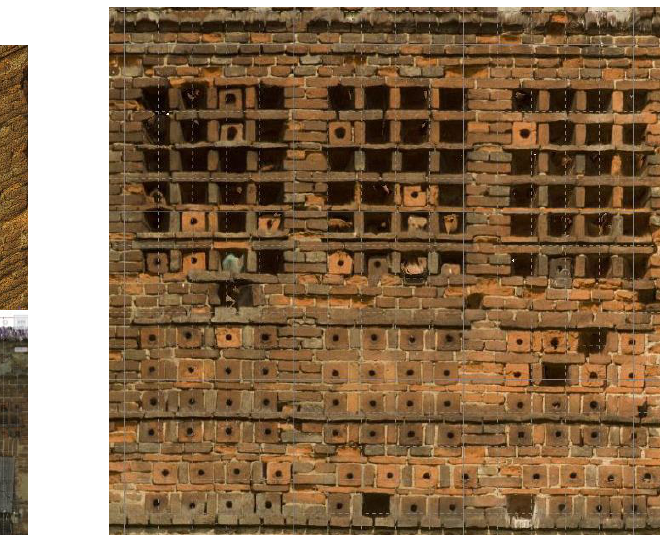
Figure 11 . Zoomed view of the dovecote on high detail